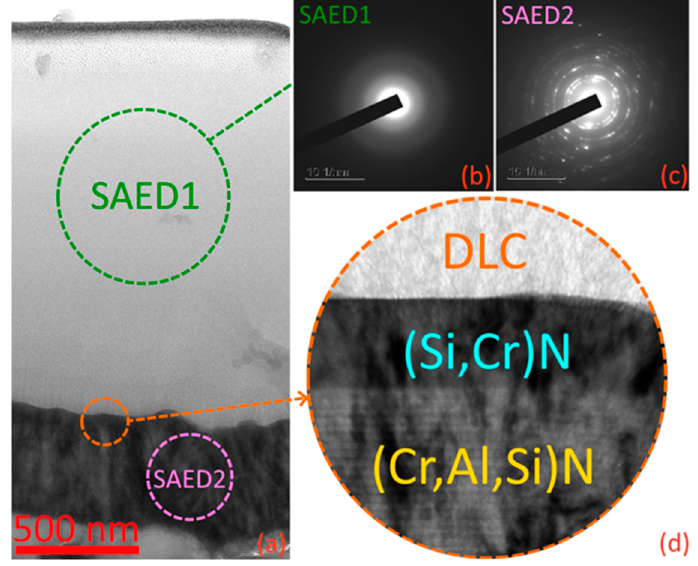
Figure 9. DLC coating with an adhesive sublayer (Cr,Al,Si)–(Si,Cr)N. ( a ) General structure of the coating layers; SAED ( b ) DLC layer and ( c ) adhesive sublayer (Cr,Al,Si)–(Si,Cr)N; ( d ) the structure of the adhesive sublayer (TEM).